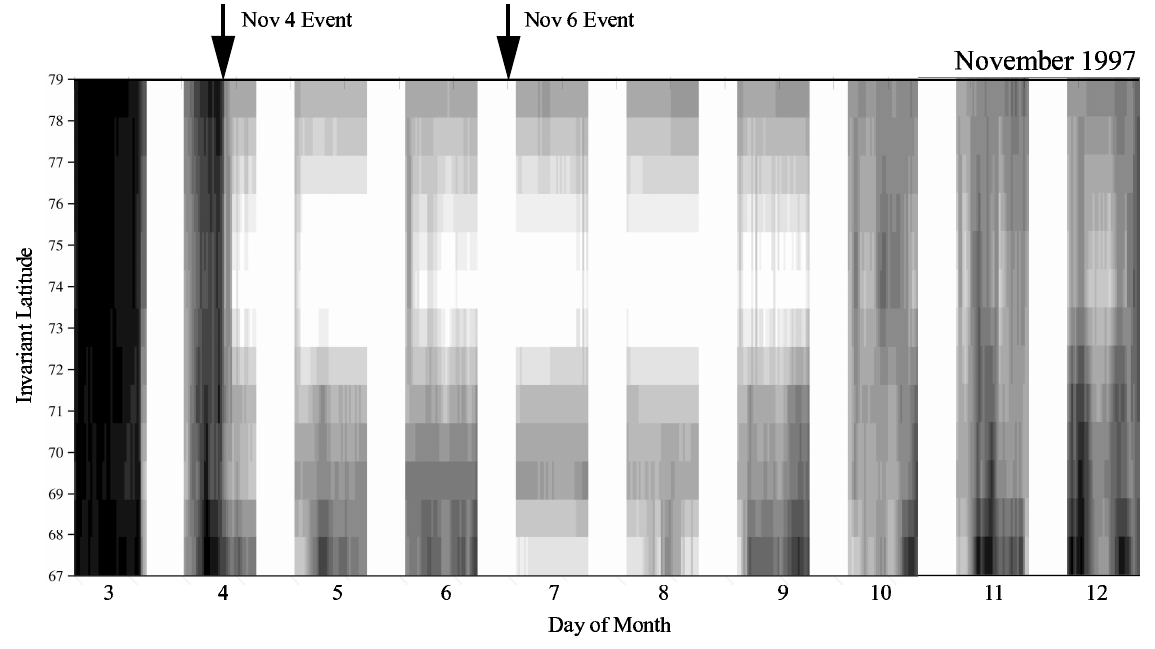
Fig. 9. Received signal power integrated over the frequency range 3.5–4.5MHz, normalized to the same parameter measured on a quiet day, as a function of invariant longitude based on data from five observatories spanning 67–79 ◦ . Only nighttime data are shown, vertical white bands indicate the data gaps corresponding to daytime, and black pixels indicate a ratio 40dB above that indicated with white pixels. Arrows indicate the times of solar flares accompanied by CMEs on 4 and 6 November